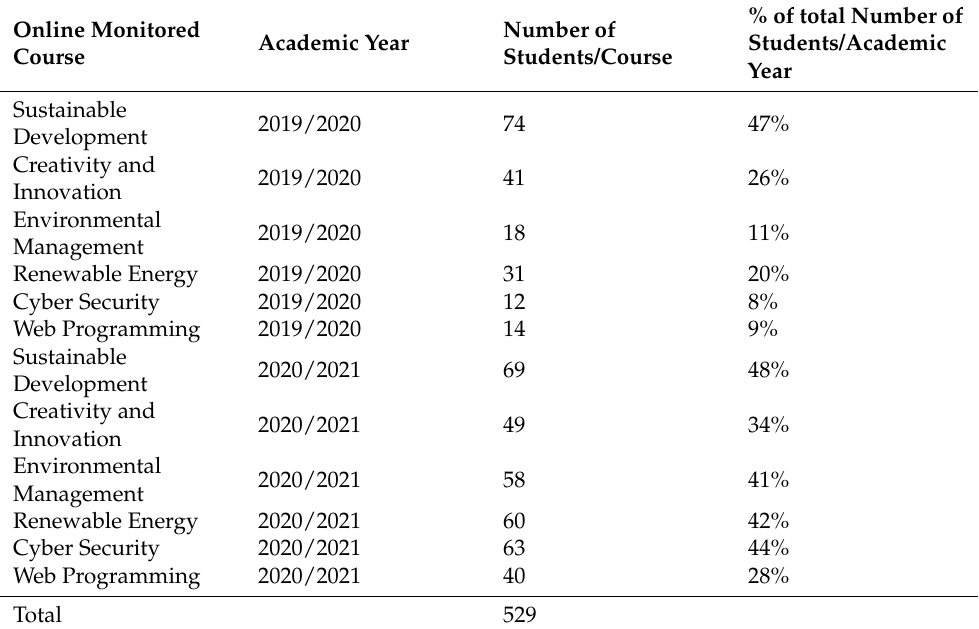
Table 2. The number of students who answered the questionnaire from the Mining and Science Faculties of the University of Petros ,